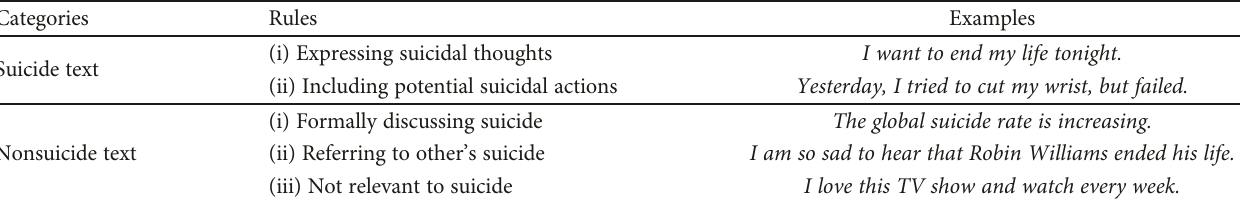
Table 1: Annotation rules and examples of social texts.